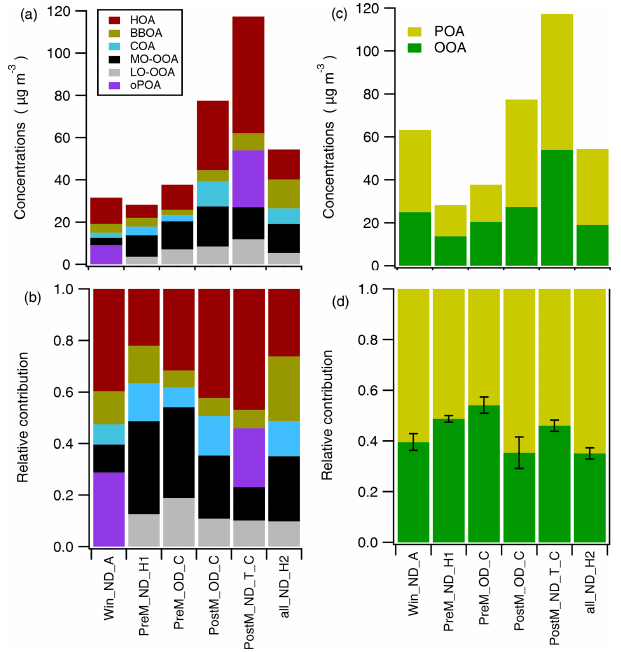
Figure 6. OA average concentrations (a) and relative contribu- tion (b) . The whiskers represent the standard deviation of the POA / OOA contribution after running PMF with different F peak values between − 1 to 1 with steps of 0.2 to prove the stability of the separation.